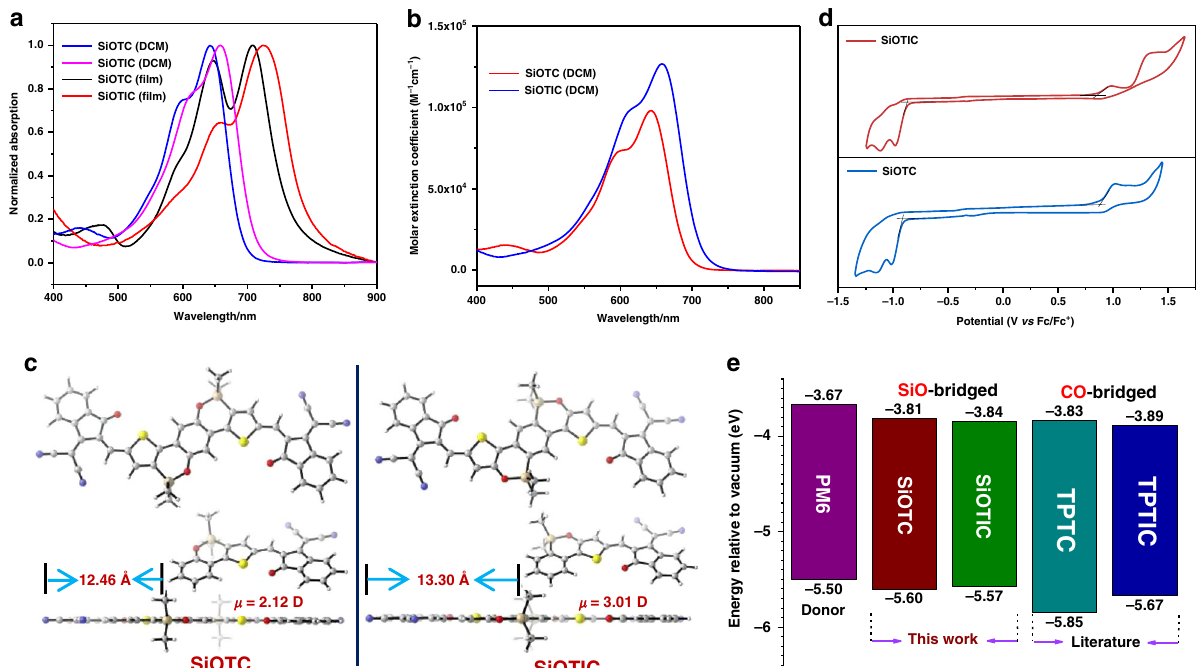
Fig. 4 Molecular physicochemical and optical properties of the acceptors. a UV – vis absorption of SiOTC and SiOTIC in DCM and fi lm. b Comparison of the molar extinction coef fi cient between SiOTC and SiOTIC in DCM. c Optimized molecular geometries of SiOTC and SiOTIC by DFT calculations. d Cyclic voltammograms of SiOTC and SiOTIC in solution. e Energy level diagram of the donor and acceptor photovoltaic